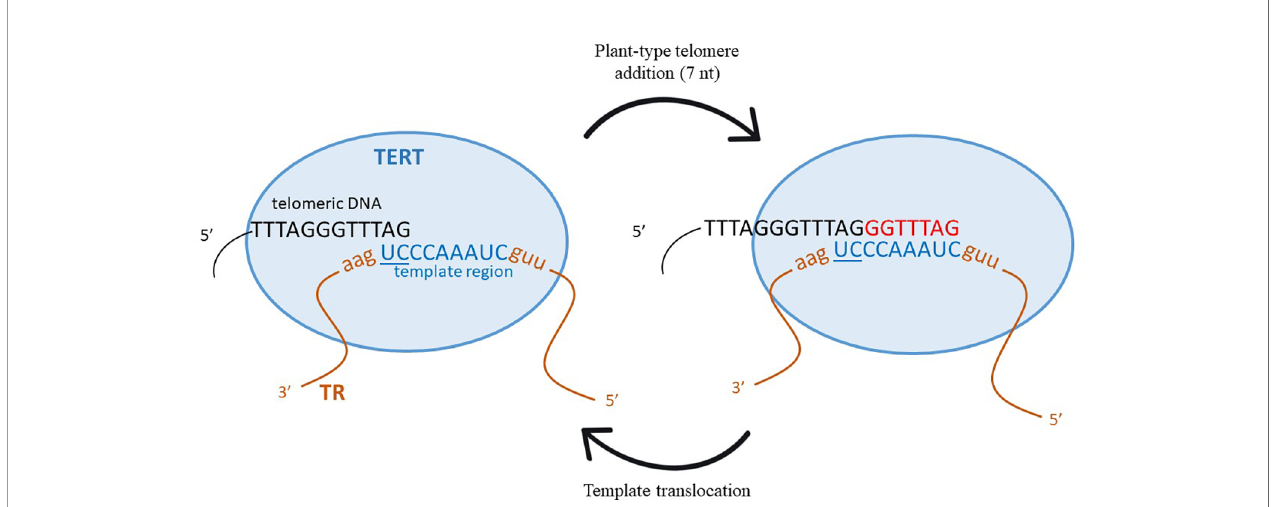
FIGURE 1 | Schematic representation of the telomerase activity cycle with the Arabidopsis -type telomere template. TERT, Telomere Reverse Transcriptase; TR, telomerase RNA subunit. Figure based on Sekhri